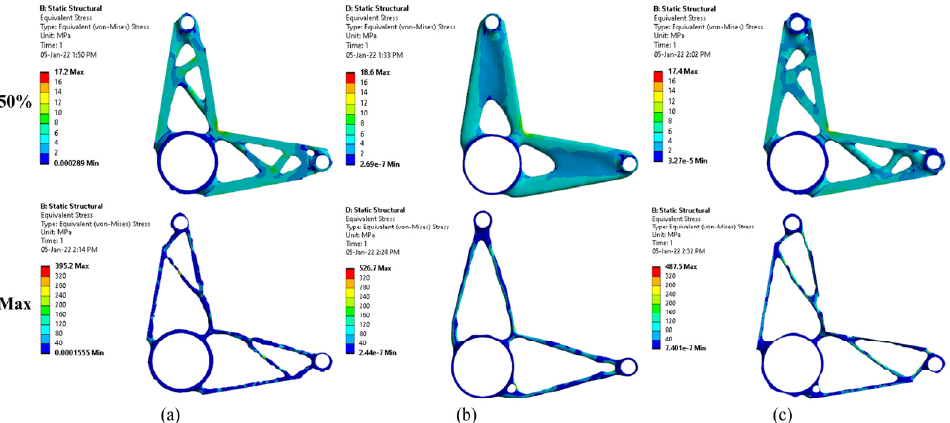
Figure 7. The results of the validation studies of bell crank lever for 50% and maximum weight reduction in ( a ) SolidWorks, ( b ) ANSYS Mechanical, and ( c ) ABAQUS. reduction in ( a ) SolidWorks, ( b ) ANSYS Mechanical, and ( c )